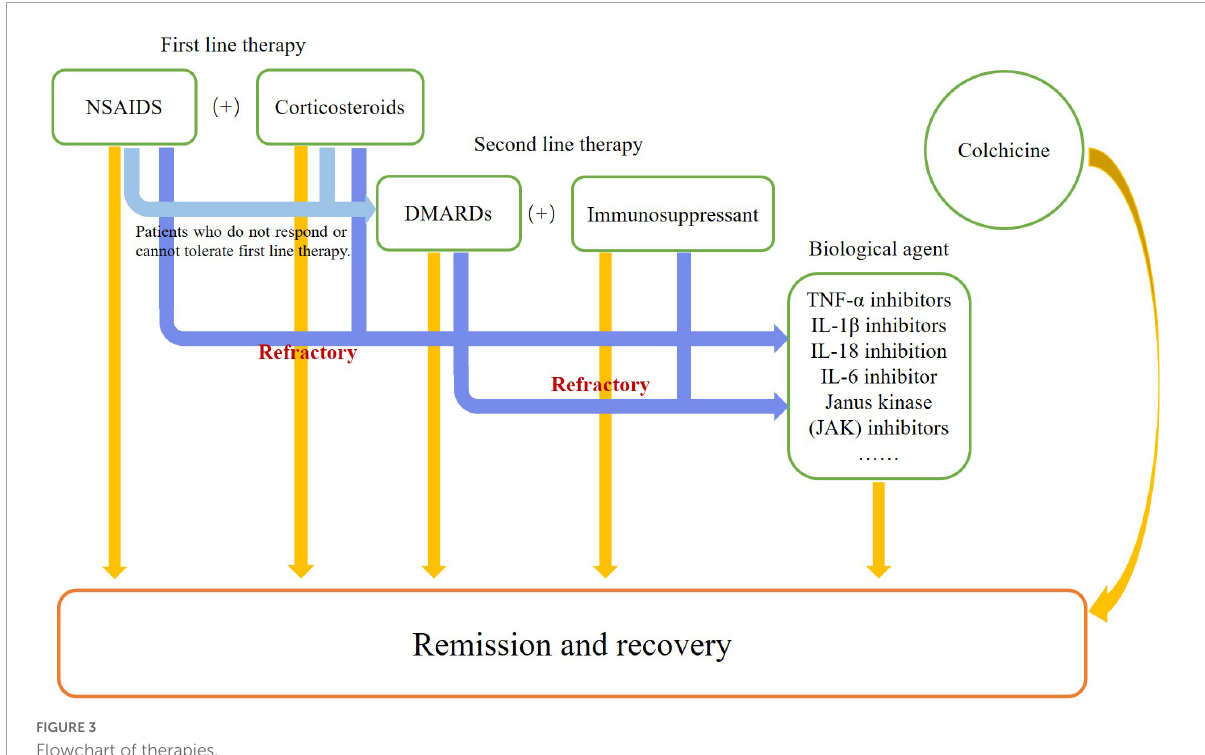
FIGURE3 Flowchart of